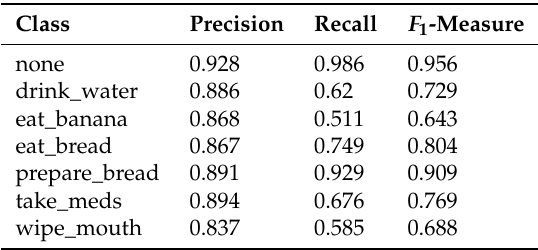
Table 3. An closer look at the results for our best configuration for each activity separately. Both vision and acceleration features were used in combination with Logistic